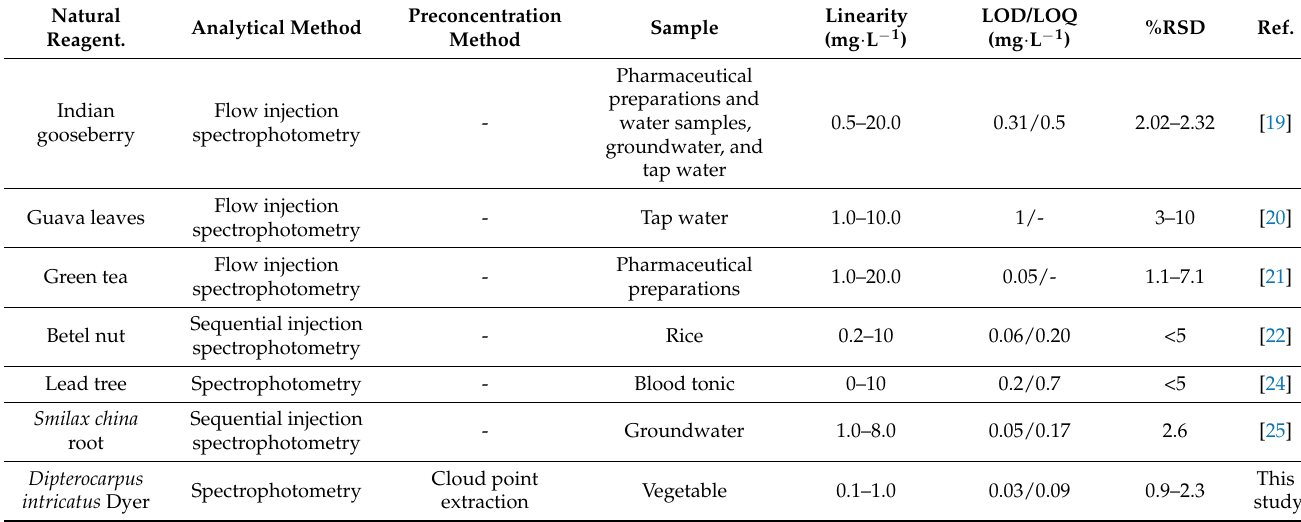
Table 1. Analytical results of figures of merit for the proposed method compared with other natural reagents.